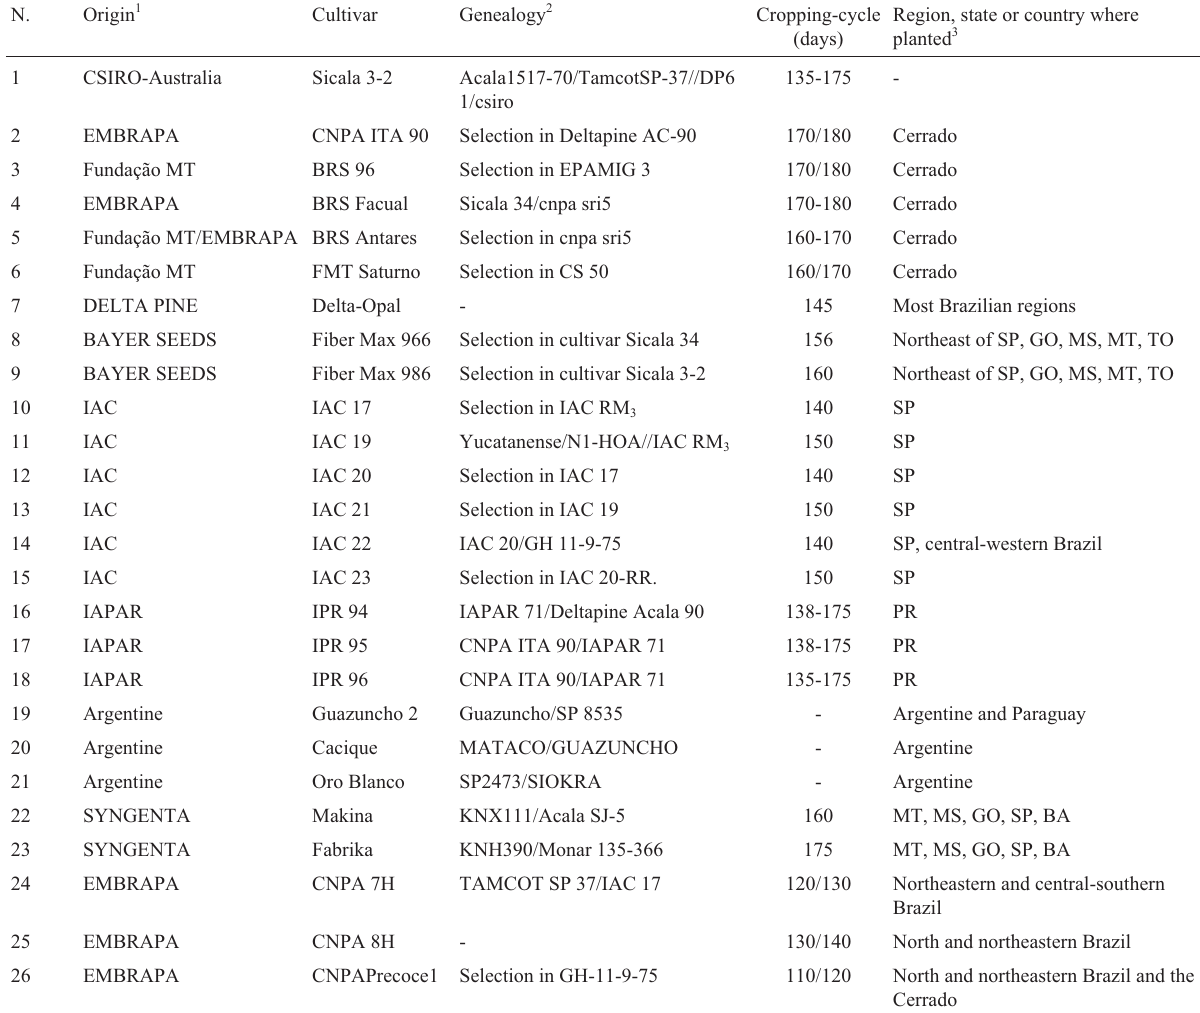
Table 1 - Cotton cultivars analyzed in this study with their descriptive data. Except for cultivars 19, 20, 21 and 43 all cultivars were from Brazil.